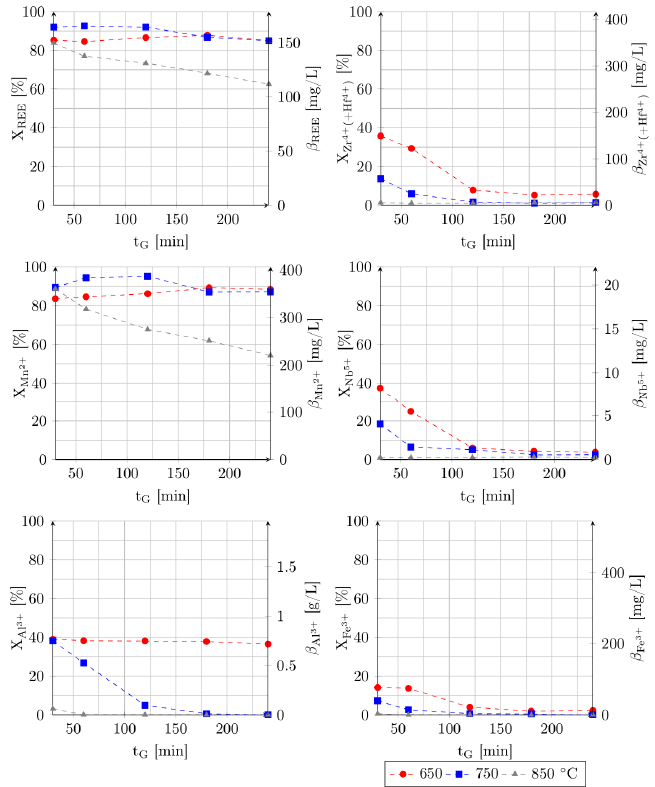
Figure 2. The effect of roasting temperature and roasting time on leaching yields (primary y-axis) and concentrations (secondary y-axis) of REEs, Zr 4+ (+Hf 4+ ), Mn 2+ , Nb 5+ , Al 3+ , Fe 3+ ( (cid:1866) H + /(cid:1865) conc. = 15 mmol/g; ϱ PD,L = 25 kg/m 3 ; T L = 20 °C; t L = 24 h; r R,L = 300 rpm).